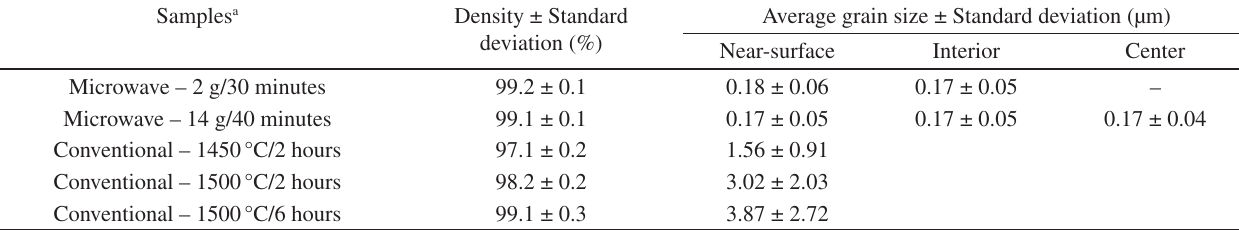
Table 1. Relative density and average grain size of microwave and conventionally sintered samples.